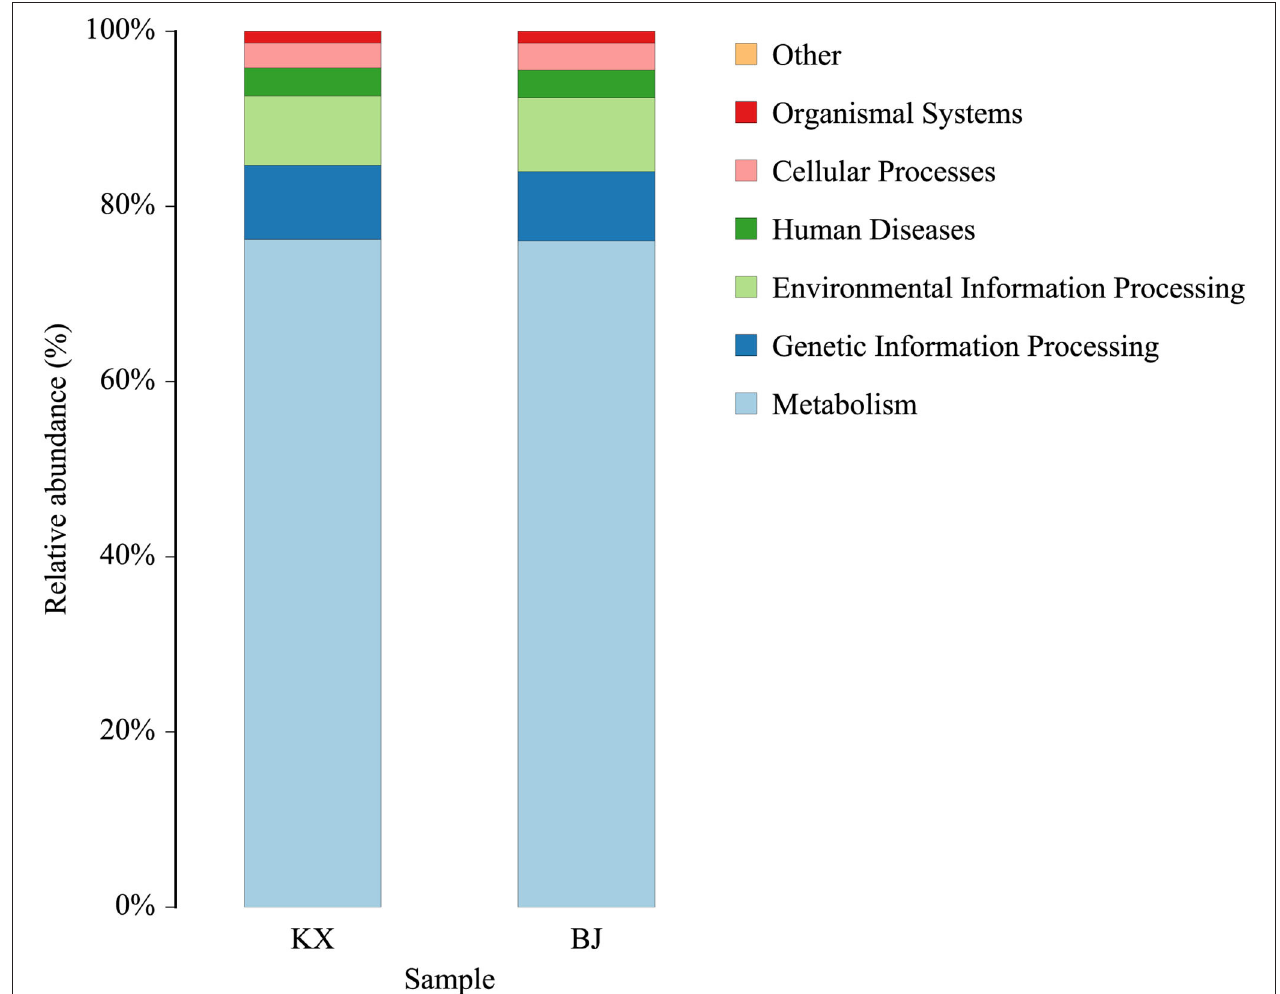
FIGURE 7 | Bacterial community functional prediction by Kyoto Encyclopedia of Genes and Genomes (KEGG)